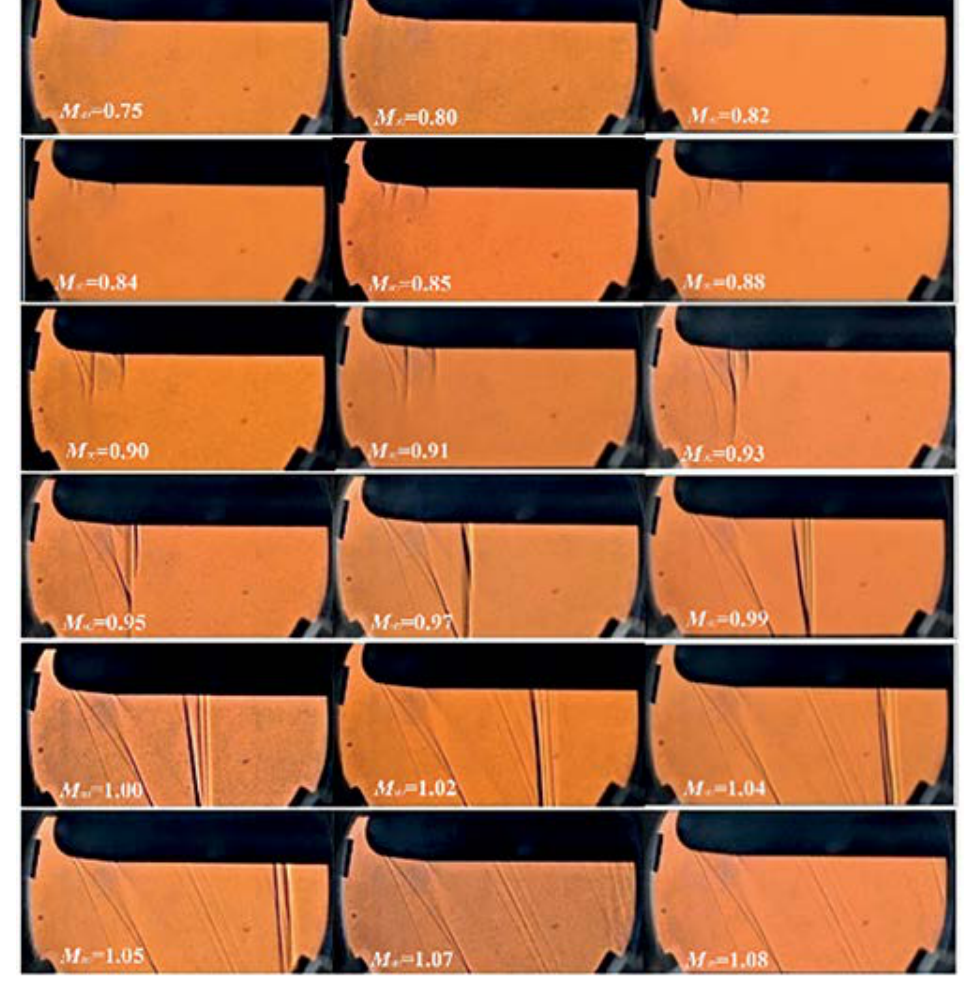
Figure 12. Schlieren images for model hemispheric forebody with a blockage area ratio of 0.78% for a stagnation pressure of 80 kPa and a stagnation temperature of about 300